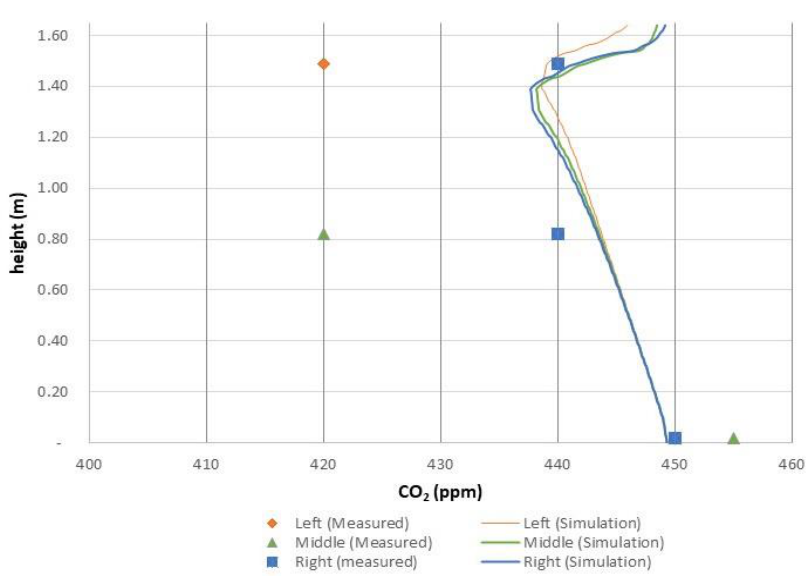
Figure 9. Measured and simulated data of CO 2 concentration inside the chamber.